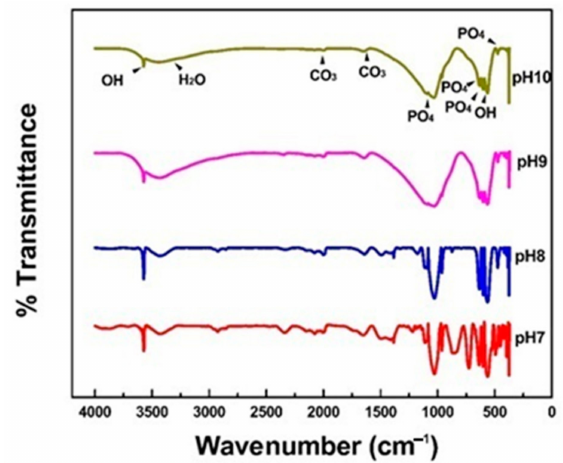
Figure 5. FTIR spectra of the HAp nanopowders synthesized at different initial pH values